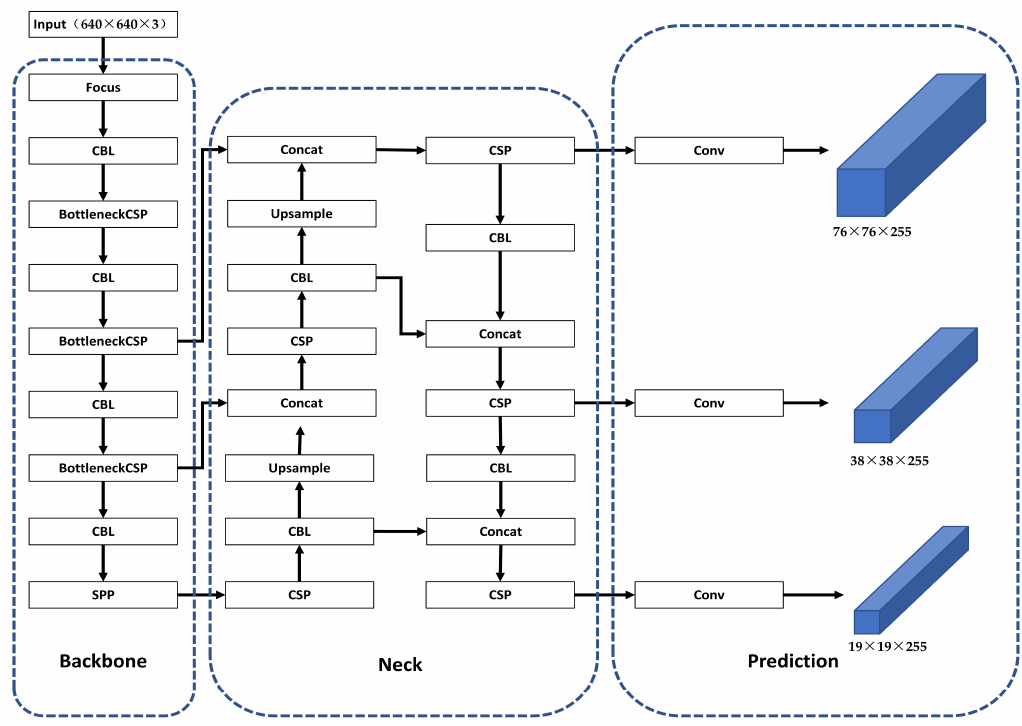
Figure 2. The structure of YOLOv5.